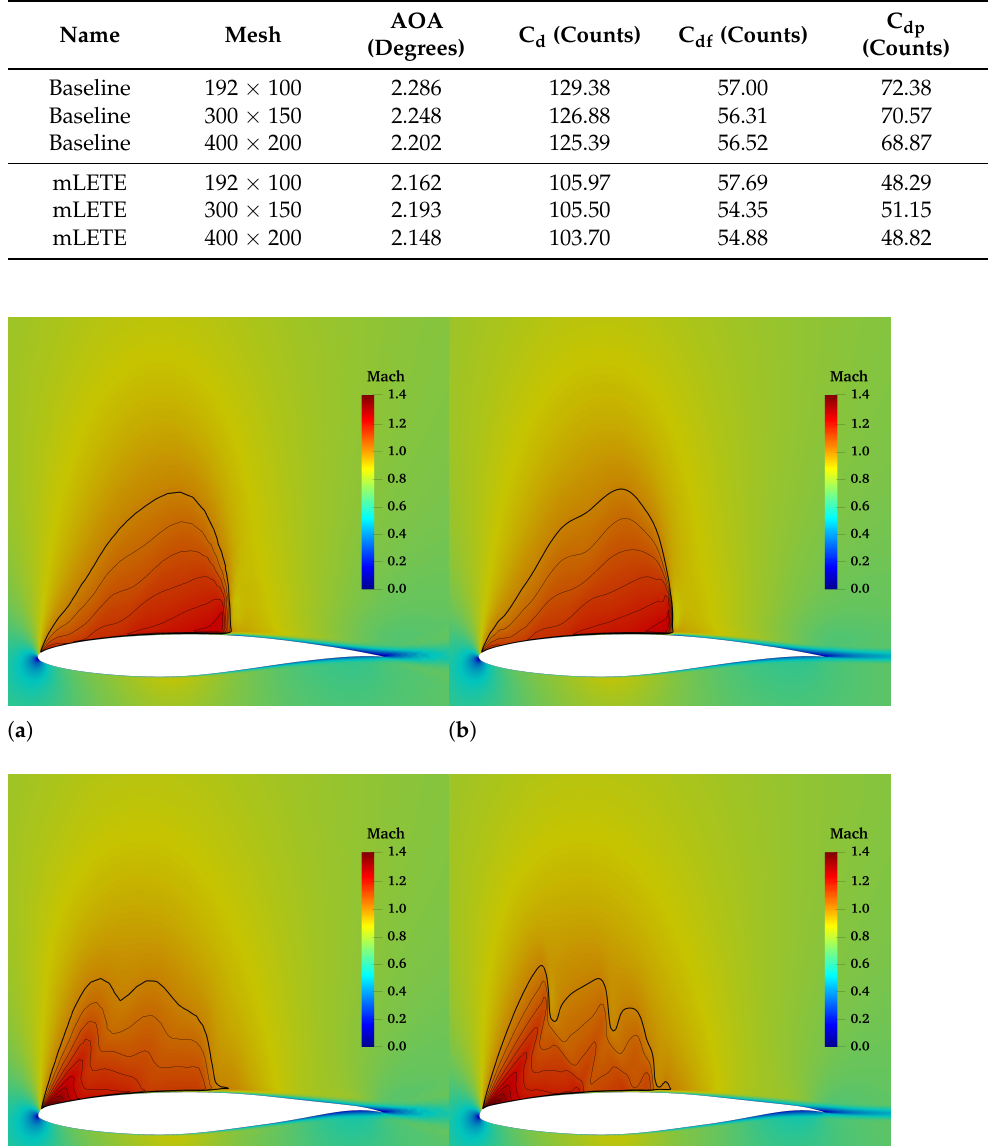
Table 2. Result verification with finer meshes.